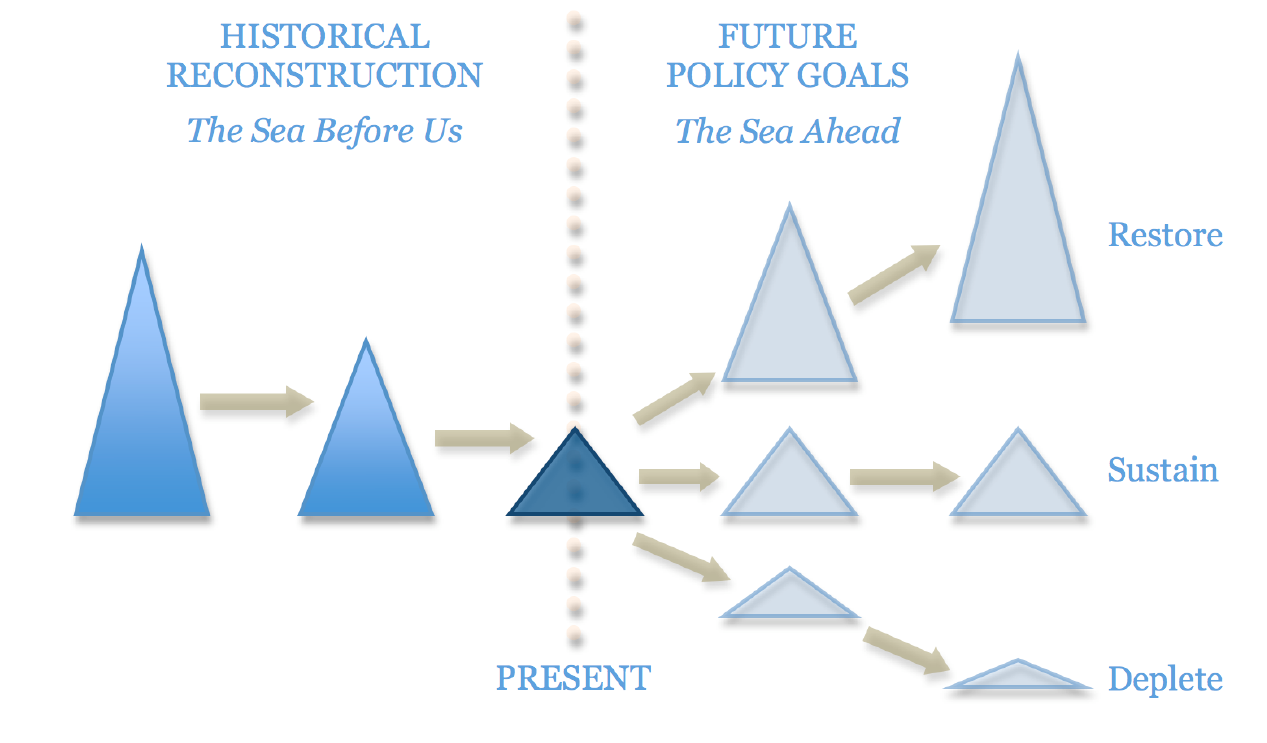
Fig. 2 . Management policy goals today should aim to restore functioning, viable and robust future ecosystems (faint triangles), informed by historical reconstructions of ancient and past ecosystems (Figure 1), The Sea Before Us, to not deplete or merely sustain, but restore future fisheries, The Sea